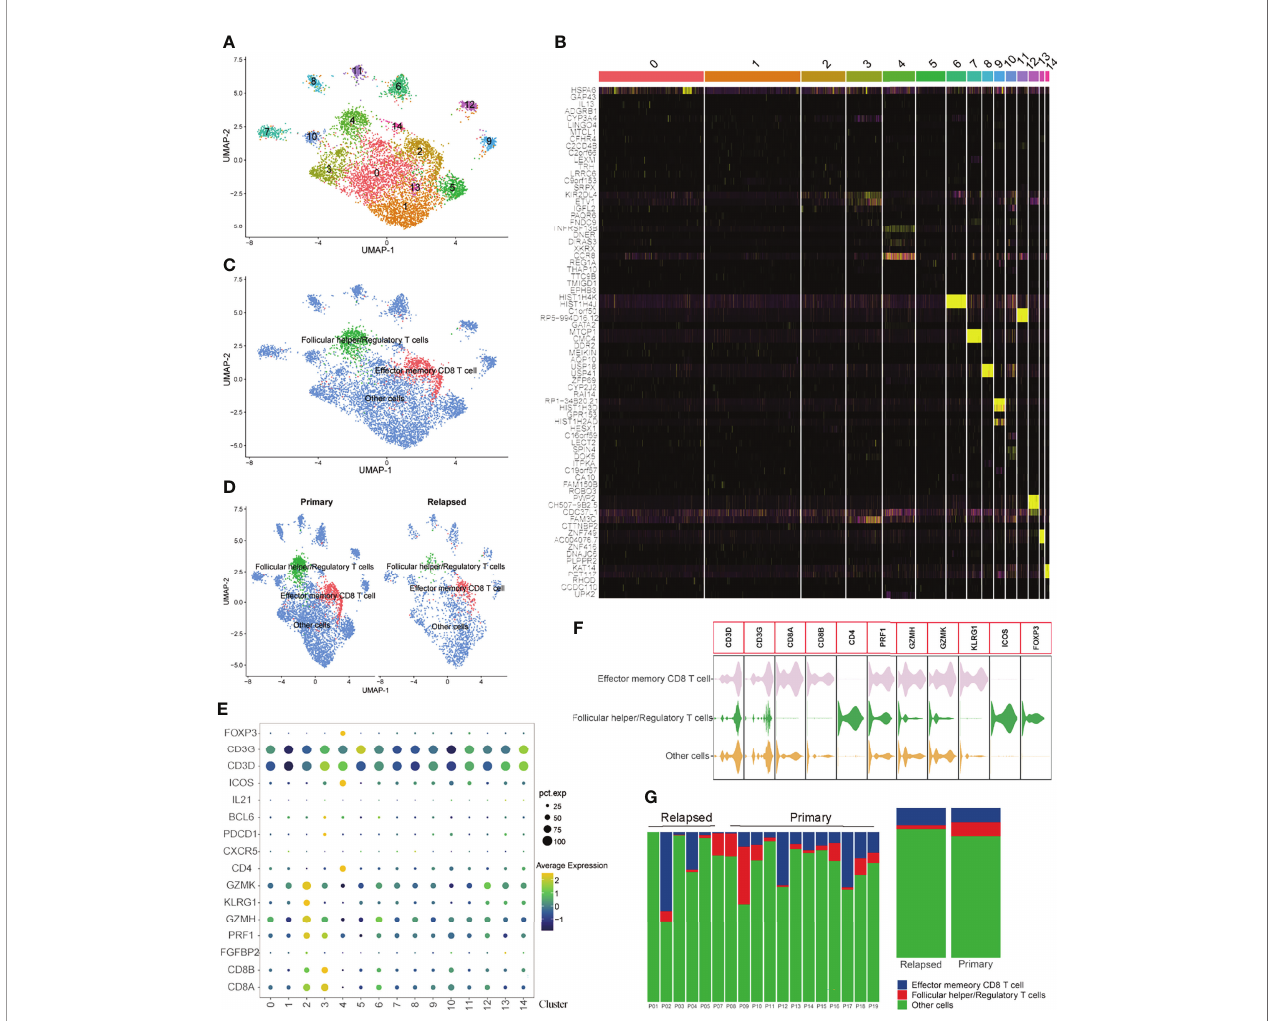
FIGURE 5 | Visualization plots of T cell scRNA-seq data. (A) UMAP plot of 5415 cells from primary HCC and 1879 cells from relapsed HCC. (B) Heatmap of the top fi ve signi fi cant DEGs in each cell cluster. (C, D) Annotations for three cell types. (E) Expression pro fi les of the marker genes in each cell cluster. (F) Violin plot of marker genes in each cell type. (G) Proportions of different T cell subtypes in each sample (left panel) or different tumor types (right